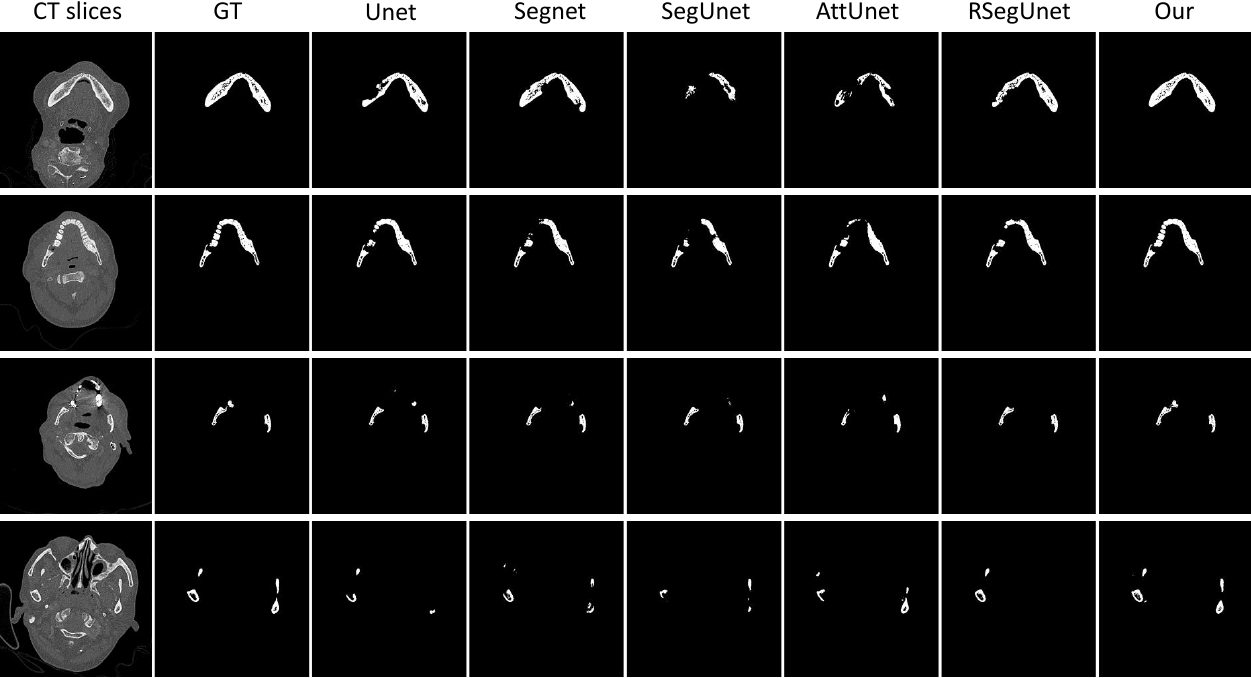
Figure 6. 2D examples from CT dataset. From left to right: Original CT slice, Ground truth (GT), Unet, Segnet, SegUnet, AttUnet, RSegUnet, and the proposed